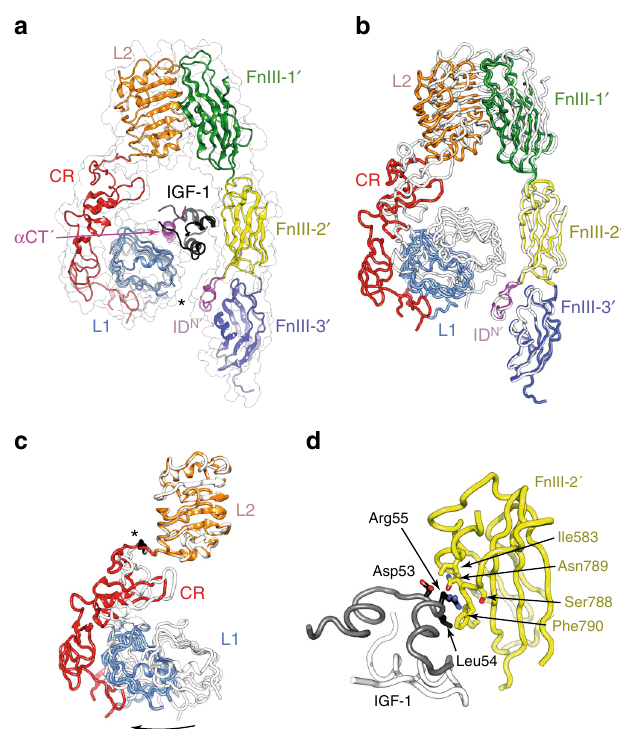
Fig. 5 Mode of IGF-I binding to IGF-1R Δβ . a Bridge formed by IGF-I (black) between the site 1 components L1 and α CT ΄ and FnIII-2 ΄ , showing separation (asterisked) of the L1-CR module away from FnIII-2 ΄ and ID N ΄ . b Overlay of one “ leg ” of the IGF-1R Δβ homodimer in its IGF-1-bound form (coloured ribbon) onto the corresponding domains of the apo IGF-1R Δβ homodimer (white ribbon). Alignment is based on domains FnIII-2 ΄ and FnIII-3 ΄ . c Overlay (via L2) of the L1-CR-L2 module of IGF-1-bound IGF-1R Δβ (coloured ribbon) onto that of apo IGF-1R Δβ (white ribbon). Pro297, the hinge point, is in black and asterisked. d Interaction between the site-1- bound IGF-I (A domain black, B domain white) and FnIII-2